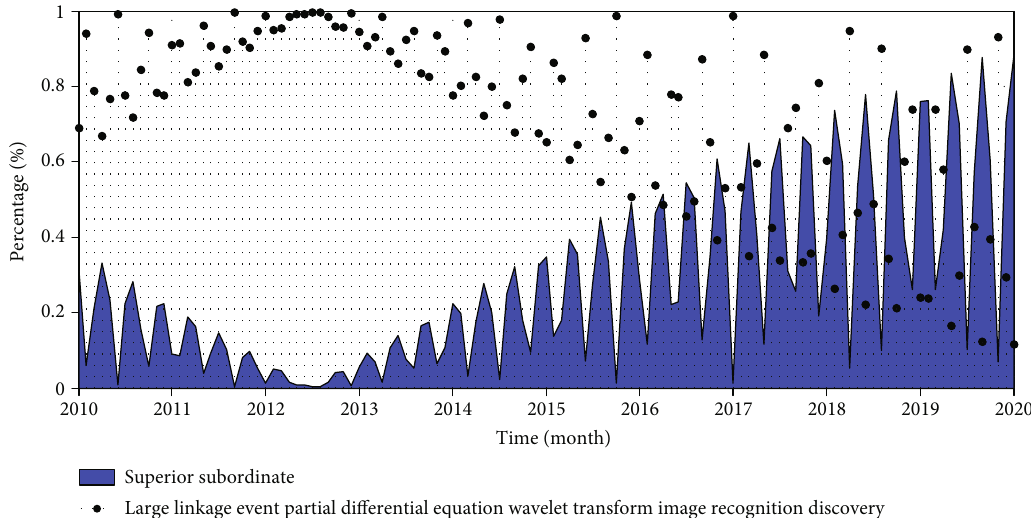
Figure 5: Comparison of the image recognition discovery of the partial di ff erential equation wavelet transform of the large-scale linkage event with the proportion of the superior and the subordinate.